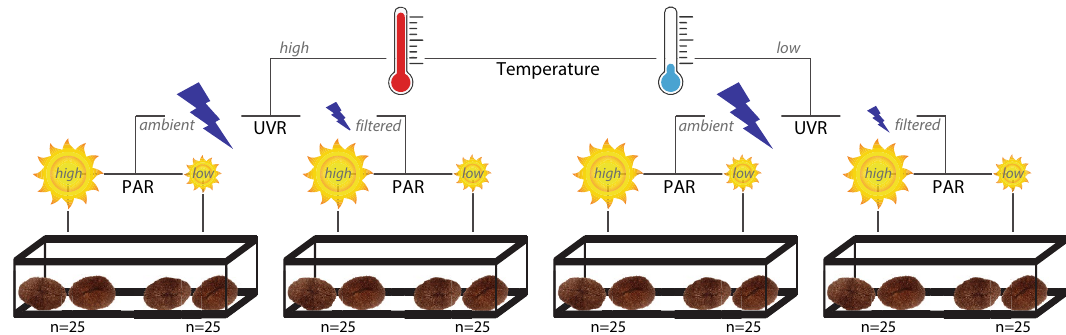
Figure 1. Summary of experimental conditions and number of L. scutaria individuals per treatment. Two hundred individuals were divided into eight treatments, each exposed to one of two levels of temperature, ultraviolet radiation (UVR), and photosynthetically active radiation (PAR). The high temperature regimen aims to follow modern temperature records from 2014 to 2019 (includes two bleaching events) and the low temperature regimen aims to follow historical temperatures from 2008–2013. Filtered UVR is 98% filtered. High PAR is 5% shaded and low PAR is 35%